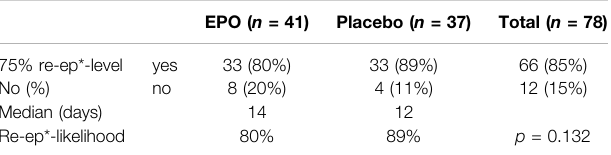
TABLE 4 | Overview of the results of the 75% re-epithelialization level of the study wound.